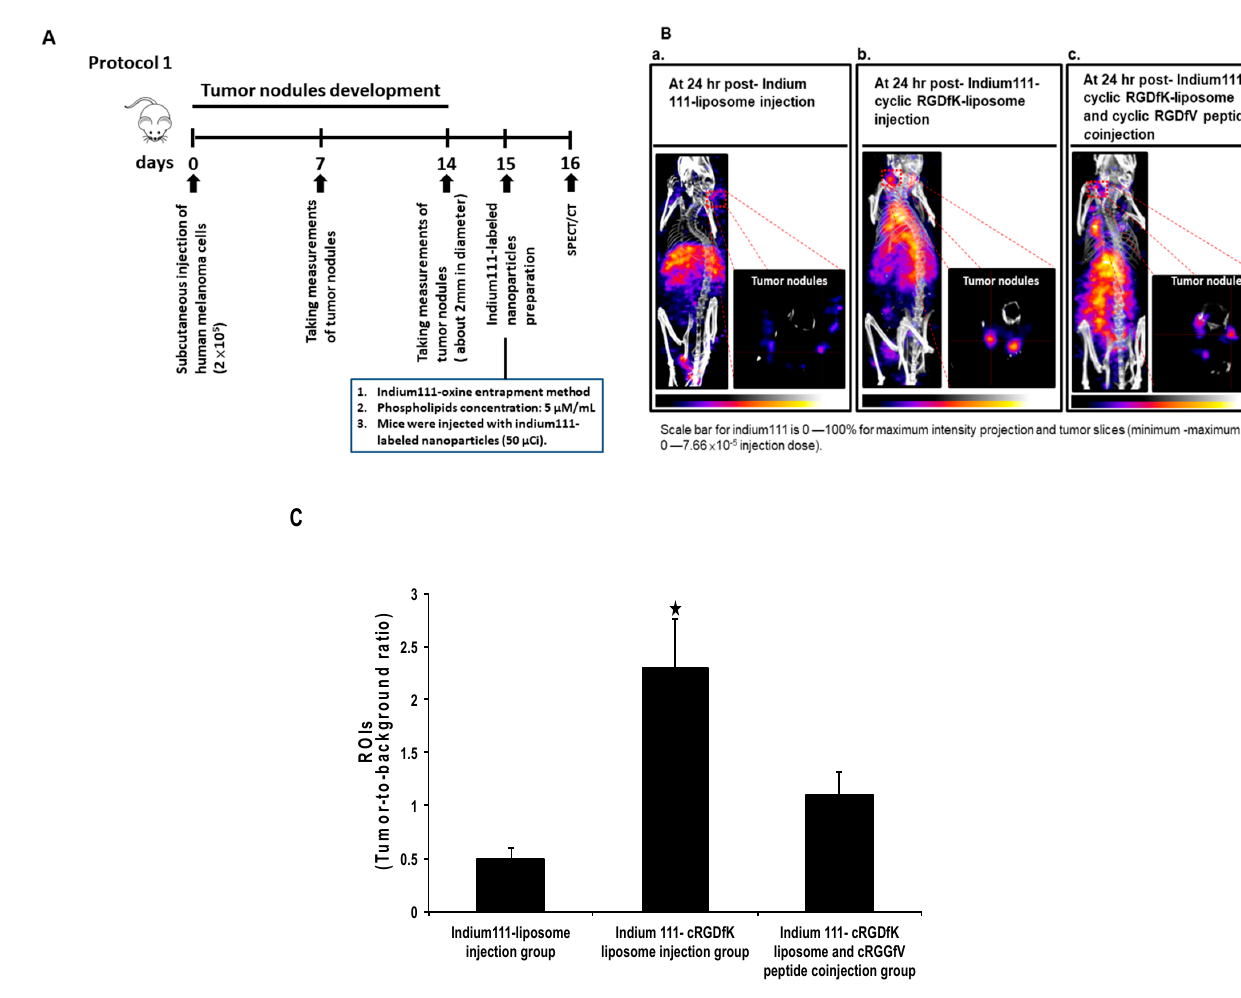
Figure 2. Non-invasive imaging with Nano SPECT/CT in mice without a metastatic growth of human melanoma cells. ( A ) Experimental scheme; ( B ) The nude mice with human melanoma were injected with the 111 In-liposome (panel a), with the 111 In-labeled-cyclic RGDfK-liposome (panel b), or with an injection of being a combination of the 111 In-labeled-cyclic RGDfK-liposome and the cyclic RGDfV peptide (panel c), and images was captured at 24 h post-radioactive liposomes injection. ( C ) The region of interest analysis of tumors was showed. The black star indicated p < 0.01, when compared to the other groups. The figure showed here was a representative example of three independent experiments in which each group consisted of three mice.